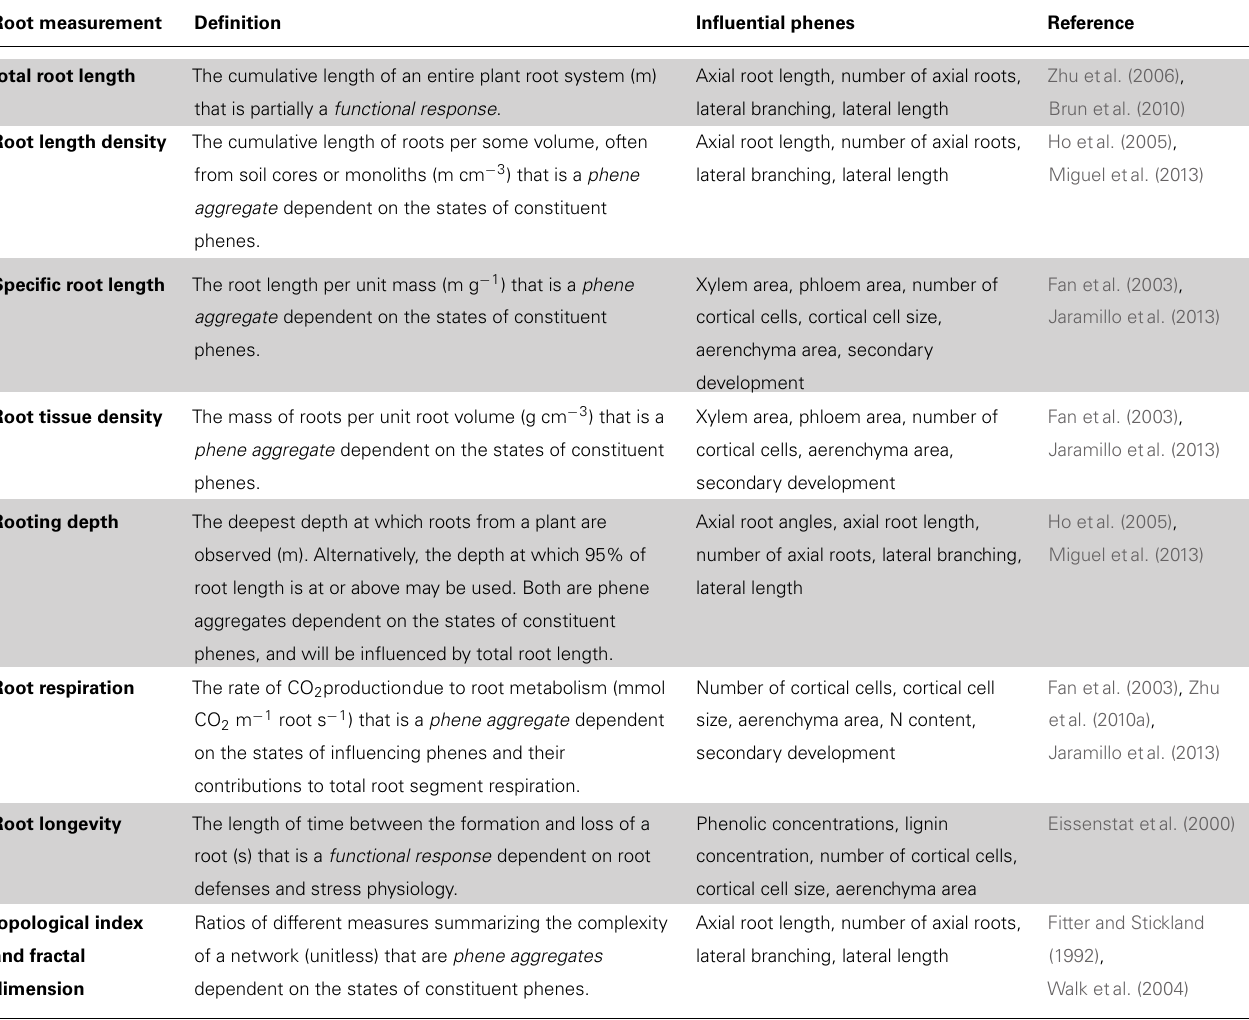
Table 2 | Relation of root measurements to root